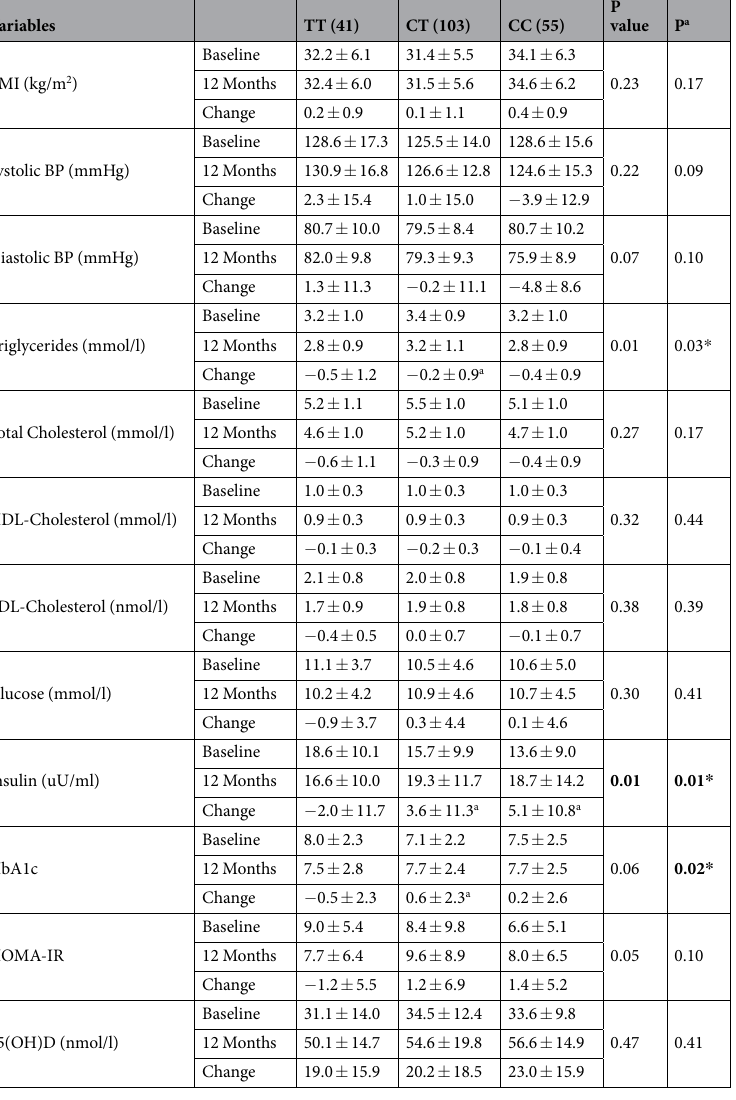
Table 5. Comparisons of the variables among the Bsm-I genotypic before and after 12 months of vitamin D supplementation. Note: Change = Follow up − Baseline; p values presented are for the changes in different variables after vitamin D supplementation according to Bsm-I genotypes; P a indicates p values after adjusting age, gender, BMI and baseline 25(OH)D levels; Superscript “a” indicates significantly different from TT group after post hoc analysis; “ * ” indicates p < 0.05 after Bonferroni